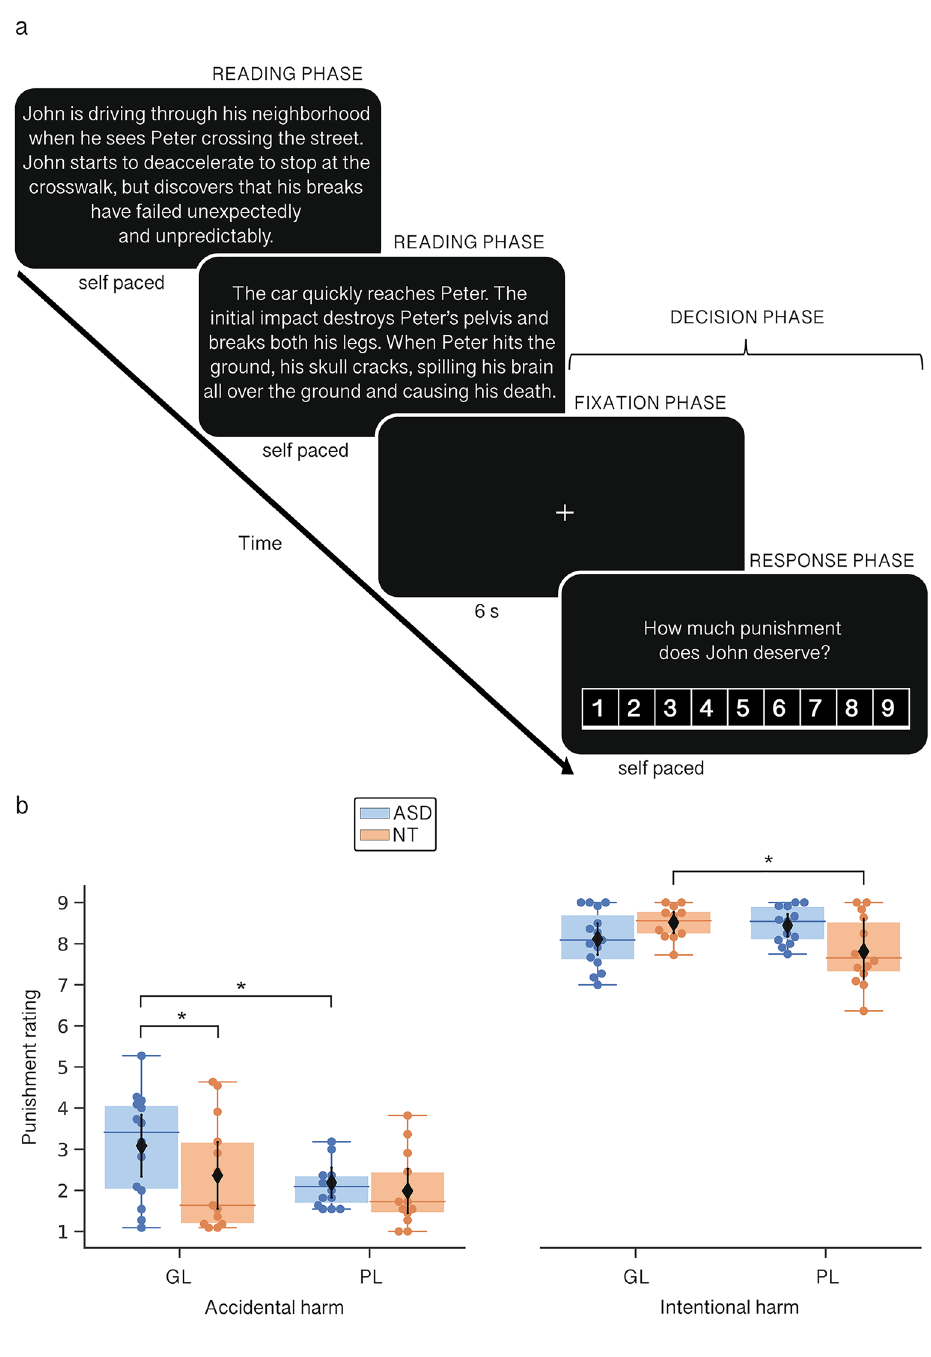
Figure 2. Moral judgment task. ( a ) fMRI task flow. Participants had to read scenarios describing a third-party harmful action and rate how much punishment the transgressor deserved in a Likert-scale. The figure displays the accidental harm condition described in GL (see Fig. 1 for the intentional harm/PL counterpart). Analysis of the fMRI data focused on the BOLD modulation during the fixation and response phases, collectively called ‘decision phase’. ( b ) Behavioral results. Under GL (vs. PL) descriptions, participants with ASD punished more severely the accidental harms and NT controls the intentional harms. Compared to NT controls, participants with ASD punished more the accidental harms described in GL. Only planned contrasts’ results are shown. The black dots and lines inside the boxplots indicate the mean and 95% CI respectively. ASD autism spectrum disorder, GL graphic language, NT neurotypical, PL plain language. * p <